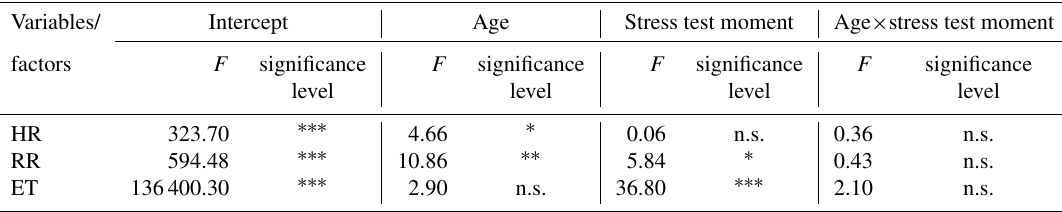
Table 2. Factorial ANOVA for every stress variable considered, due to age and stress test moment factors, including the age × stress test moment interaction factor.